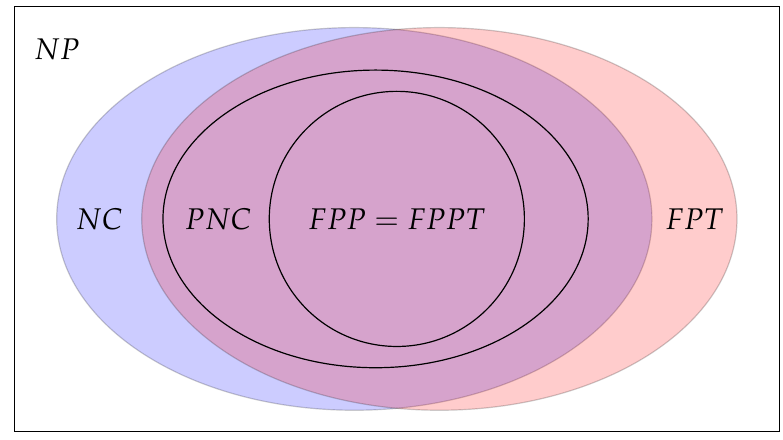
Figure 1. FPPT = FPP ⊂ PNC ⊂ NC and FPPT = FPP ⊂ PNC ⊂ FPT